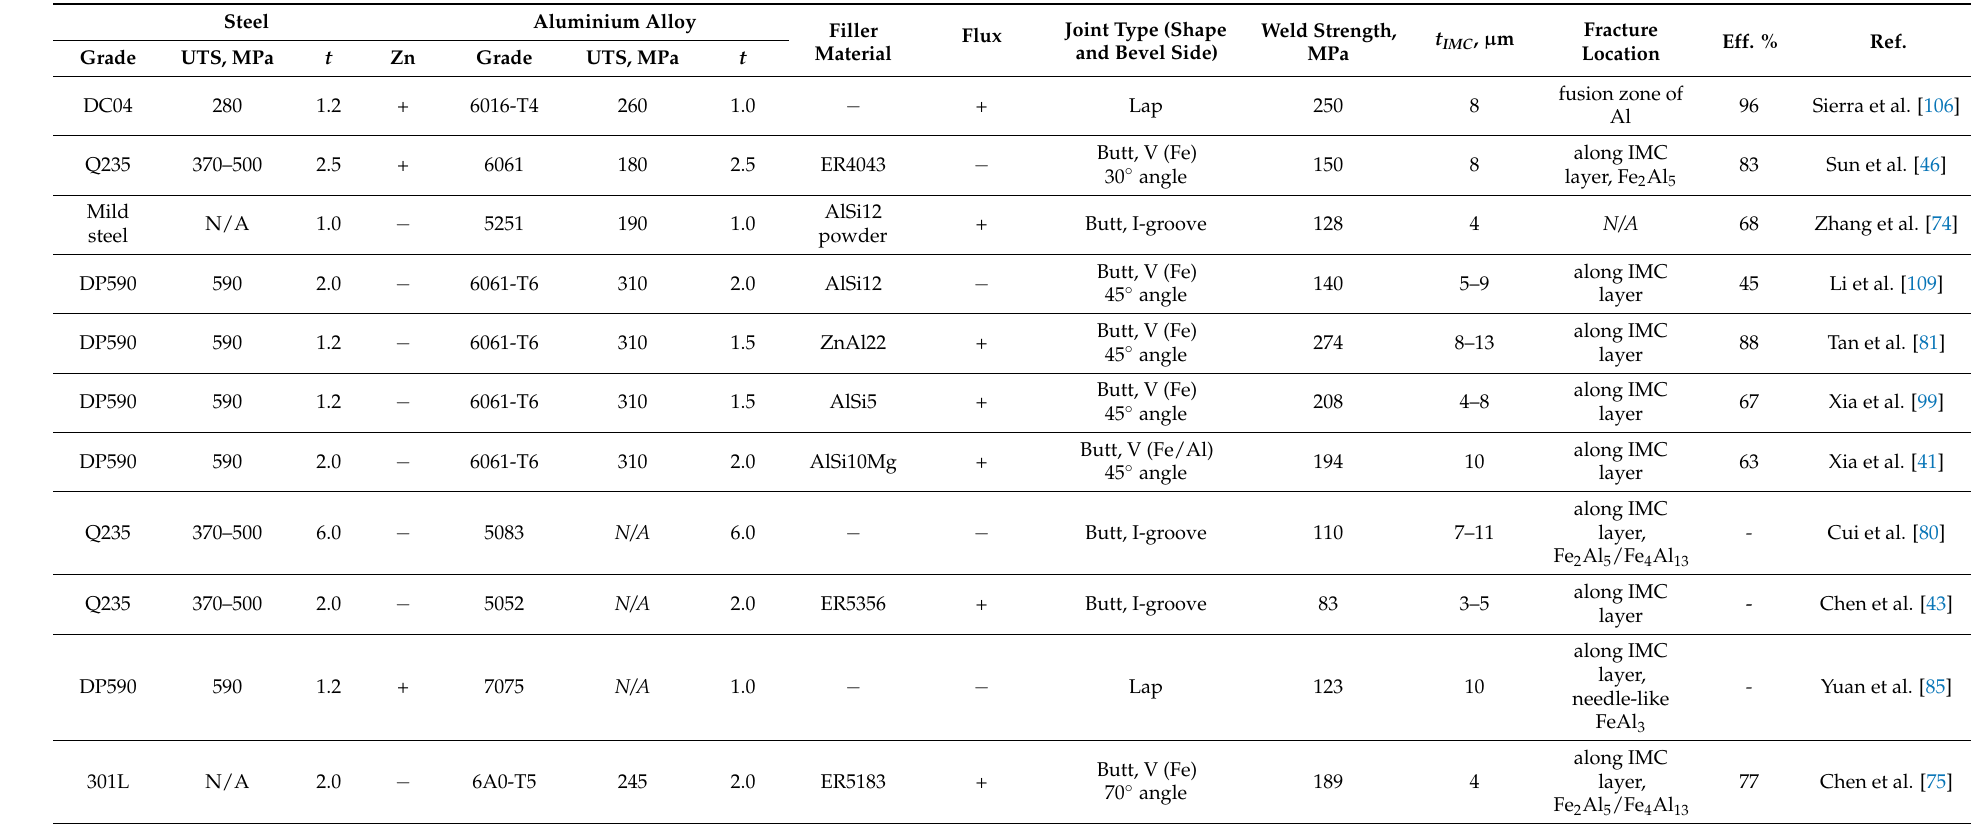
Table 3. Strength of welds between steel and aluminium by using laser beam and laser-assisted hybrid welding–brazing. Abbreviations: t is thickness is specimen (in mm), UTS is ultimate tensile strength, t IMC is thickness of IMC layer, Zn is zinc-coated steel where (+) means it was used and ( − ) was not, the same for the flux. Strength efficiency (denoted as Eff. in %) means the strength of joint comparable to used aluminium alloy strength. Indicated weld strength is max. achieved strength under certain (optimised) welding